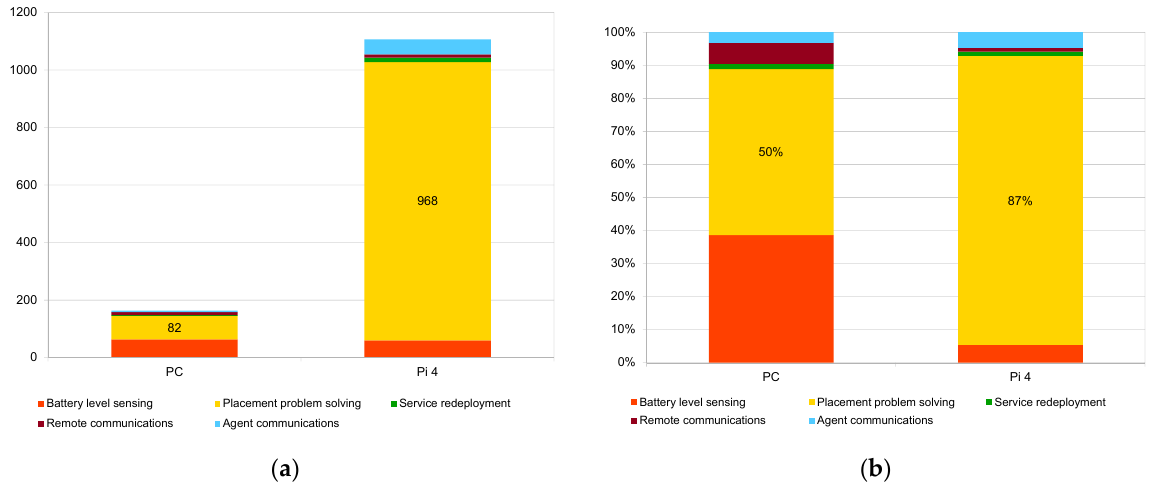
Figure 11 . Evaluation of service redistribution latency: ( a ) Absolute latency; ( b ) Relative latency caused by different parts of the placement algorithm.